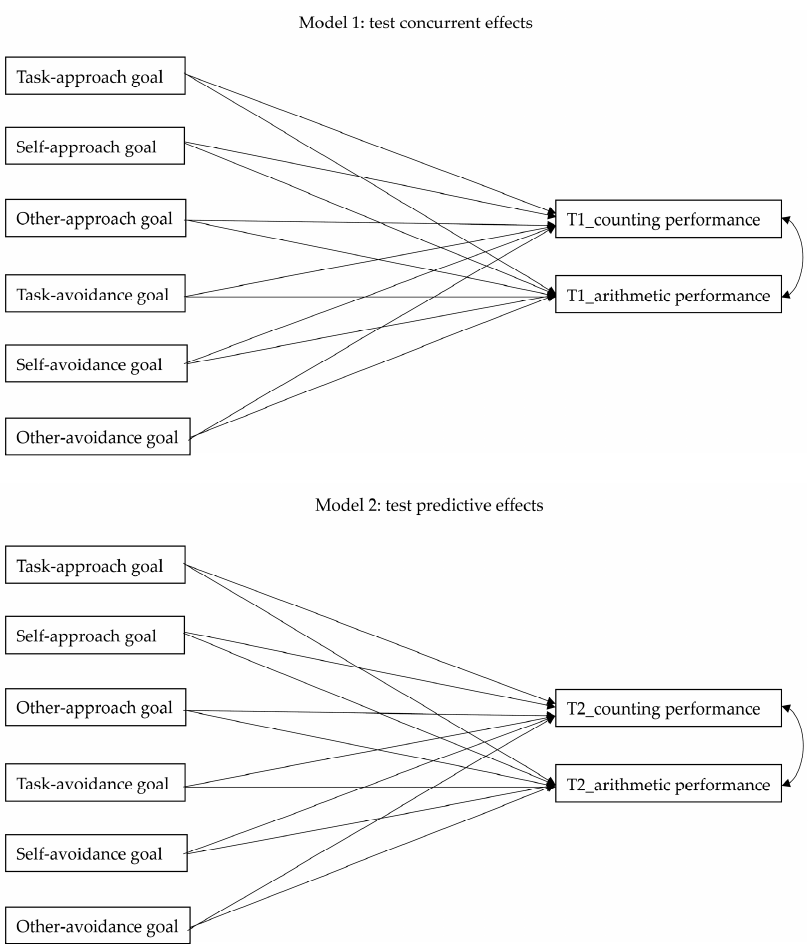
Figure 1. Path models of the effects of achievement goal and mathematics performance. Note. T1 = the first time point of data collection; T2 = the last time point of data collection. For simplicity, intercorrelations among achievement goals are not presented in the